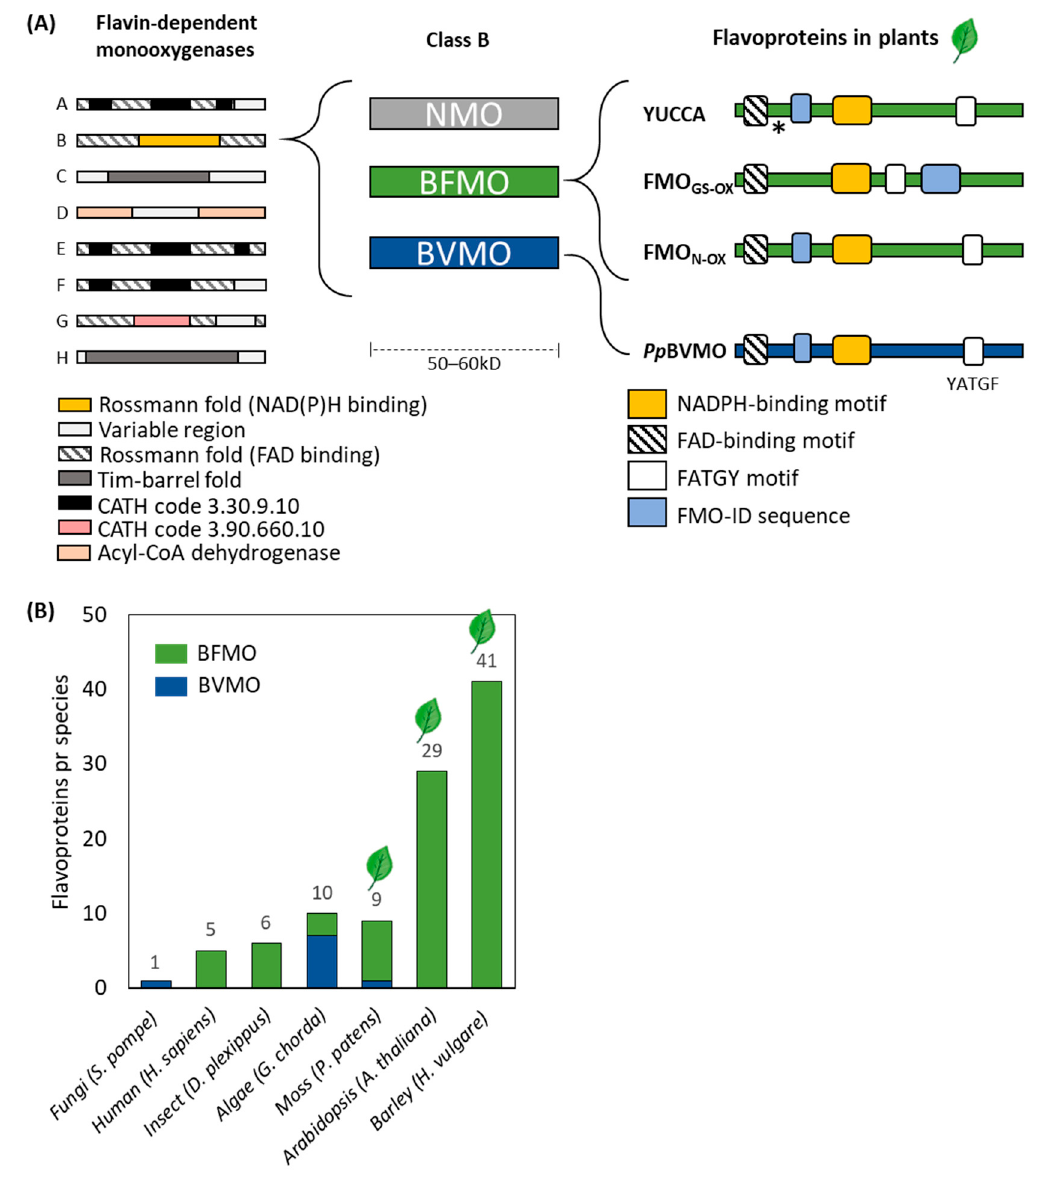
Figure 1. An overview of flavin-dependent monooxygenases and flavoproteins in plants. ( A ) Flavin- dependent monooxygenases (FMOs) are separated into eight classes, A–H. Schematic representation of the classes is shown, with corresponding CATH domains folds (modified from [25]). All plants possess Class B FMOs, which consist of two Rossmann folds (CATH code 3.50.50.60), a NADPH binding site (yellow) and a FAD binding site (grey, and split into two domains). Class B flavoproteins consist of three distinct sub-classes: N-hydroxylating monooxygenases (NHMO), Class B Flavoproteins (BFMOs) and Baeyer-Villiger monooxygenases (BVMOs). An overview of the flavoproteins identified in plants illustrates the distribution and alignment of the FAD and NADPH binding sites, the FATGY motif and the FMO-identifier motif in three types of Arabidopsis BFMO proteins, and the P. patens BVMO. The asterix denotes a conserved cysteine in Arabidopsis YUCCAs. ( B ) Examples of Class B FMO diversity across kingdoms, with the number of BFMOs selected from single and multicellular organisms as acquired from online resources (see Supplementary Materials DataS1 file for further details).